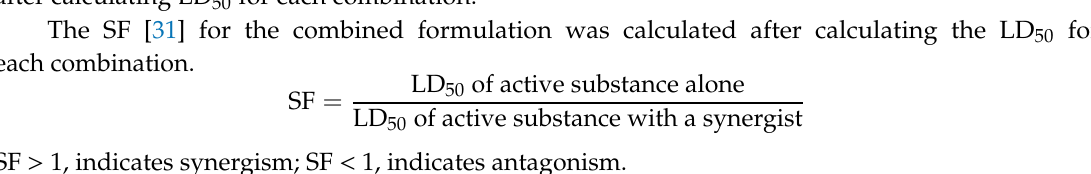
Table 1. Variation of permethrin and deltamethrin concentrations for combining with three EOs (LD 25 ). Combination [insecticides-EOs (LD 25 )]